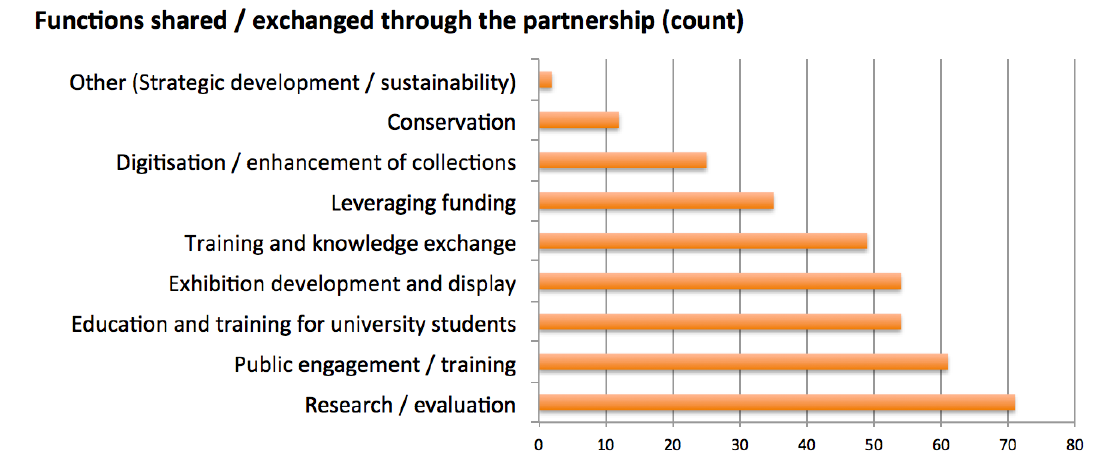
Figure 5. Functions that are shared or exchanged by organisations taking part in museum university partnerships, as shown by survey data.